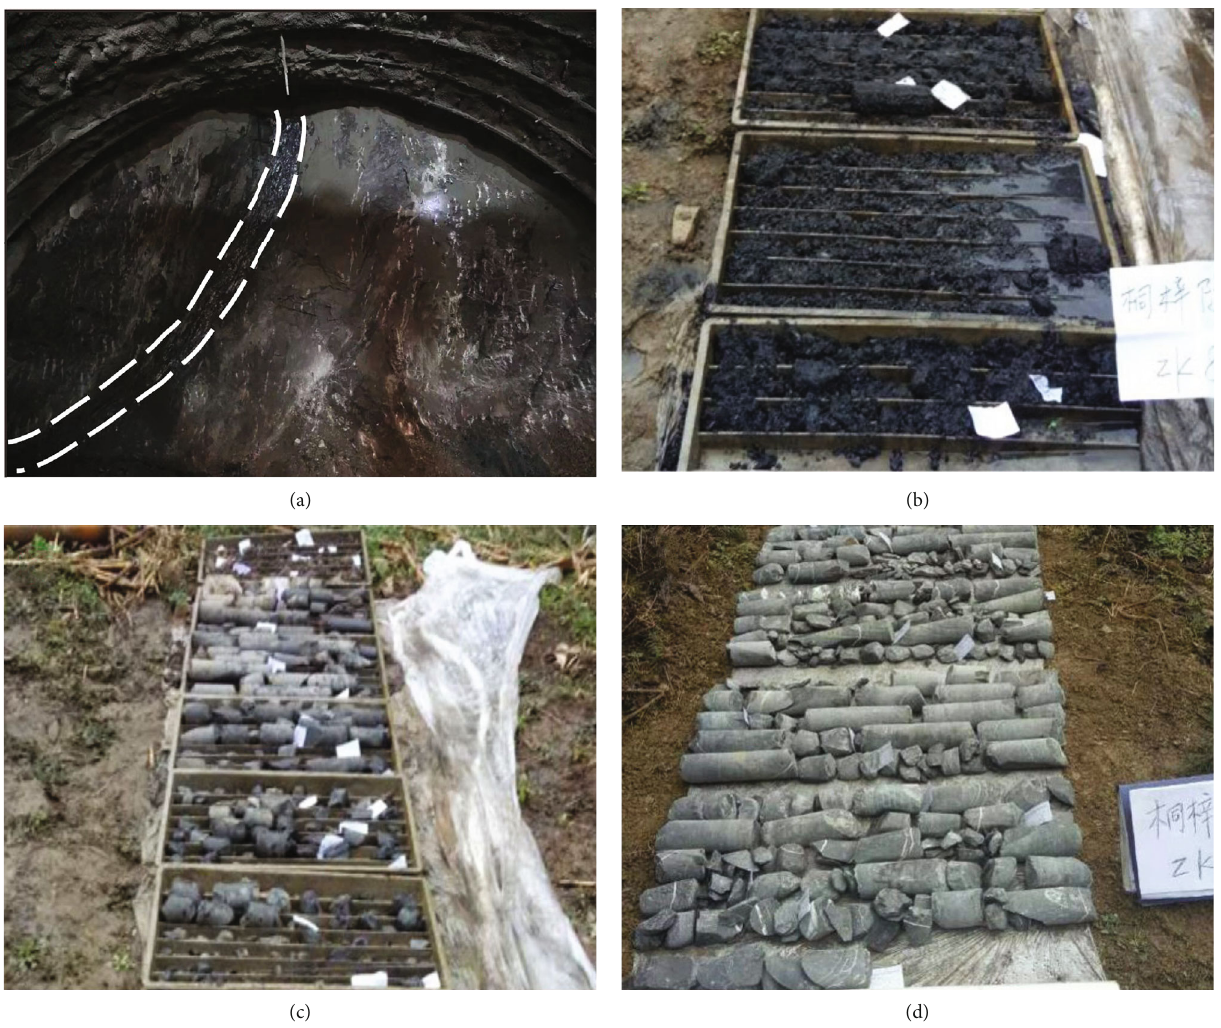
Figure 3: Stratigraphic samples. (a) Coal seam on the tunnel face. (b) Coal seam. (c) Limestone intercalated with mudstone. (d)